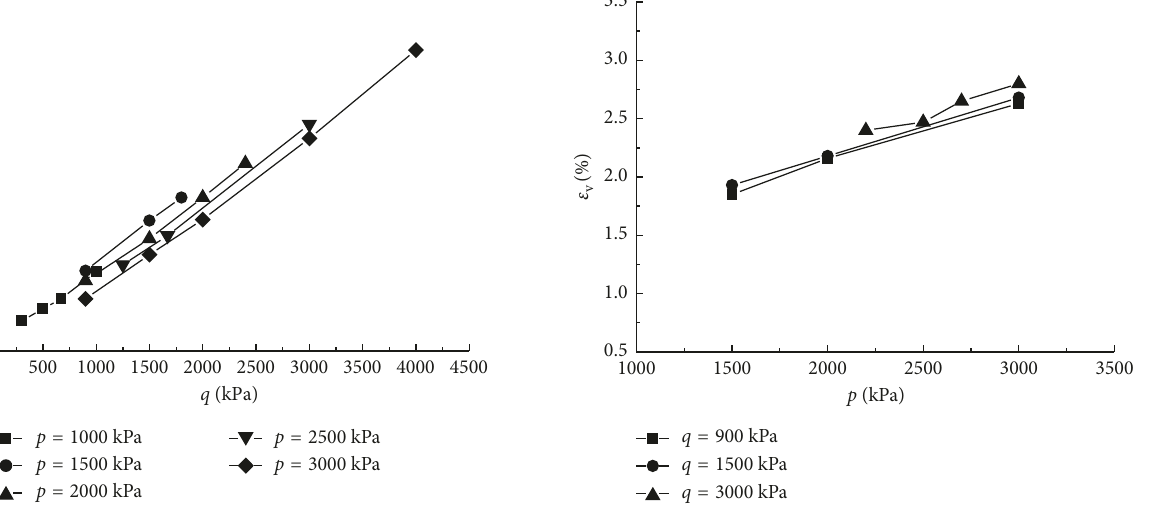
Figure 5: p versus ε v curve (stress conditions of equal q and unequal p ).